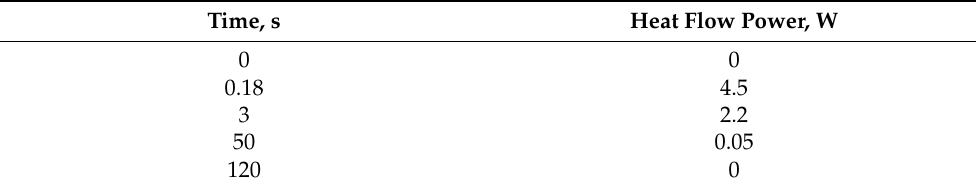
Table 4. Excitation heat flow parameters.